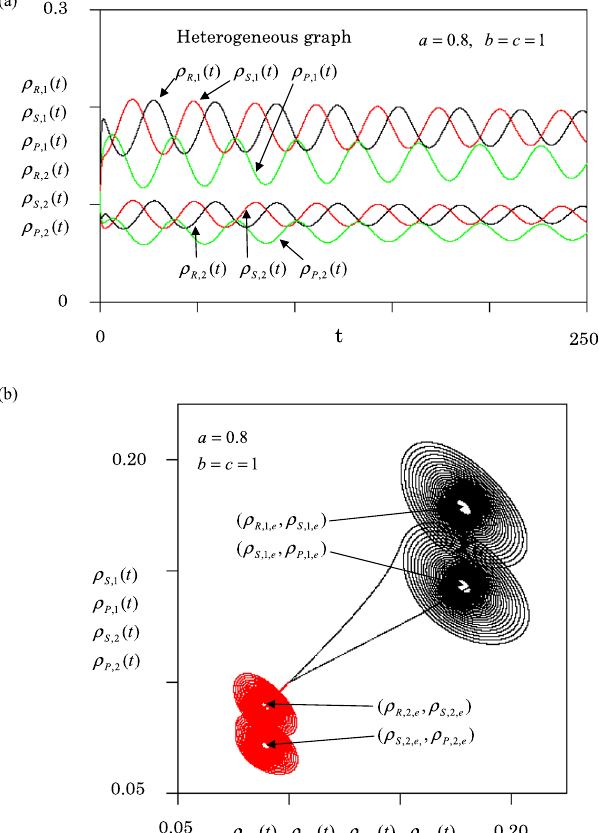
Figure 6. Same as Fig. 5, but for heterogeneous graph. ( a ) Population dynamics. Upper three curves denote the three densities in node 1, while lower three curves mean those in node 2. ( b ) Four orbits. Black curves denote orbits of ( ρ R ,1 ( t ),